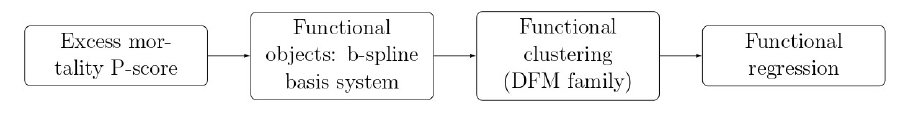
Figure 1. Statistical analysis